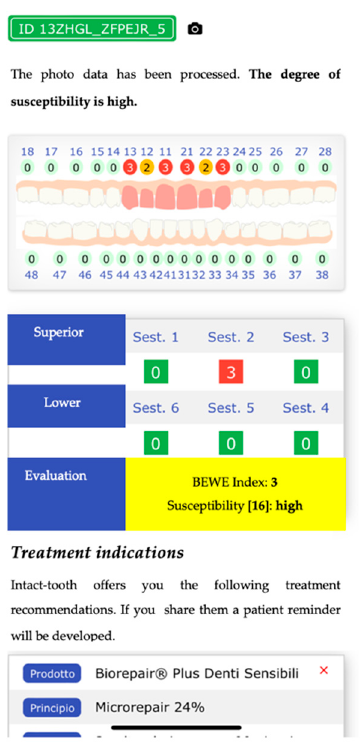
Figure 2. Shows the numerical assessment of erosion present on the elements, allowing a value from 0 to 3 to be awarded.